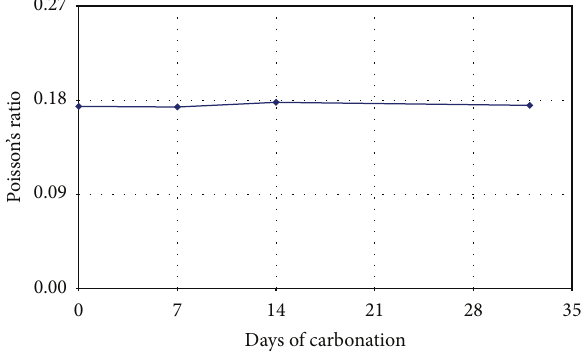
Figure 15: Evolution of the Poisson’s ratio during